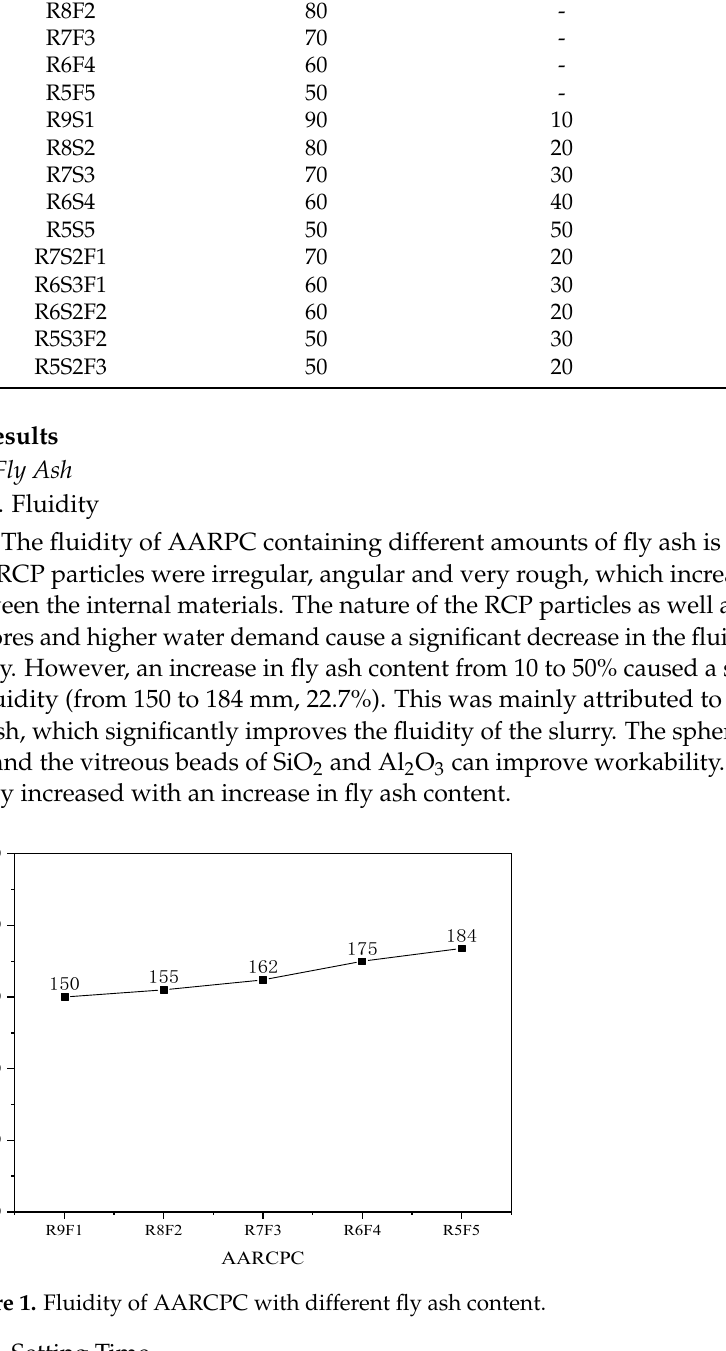
Figure 2. Setting time of AARCPC with different fly ash content. 3.1.3. Strength Figure 3 shows the development trend of compressive strength of AARCPC with dif- ferent fly ash content. There was only a slight difference in the compressive strength among AARCPCs with different fly ash content. The compressive strength of R9F1 and R5F5 was 18.8 MPa and 19.2 MPa, respectively. Our findings suggest that fly ash content and RCP have similar effects on the compressive strength, which was consistent with re- sults obtained from other studies [24]. Fly ash has insufficient activity and reacts slowly in an alkali-activated system, so the compressive strength results with different dosages of fly ash and RCP were close. During the alkali-activated reaction, Si-O-Si, Si-O-Al and